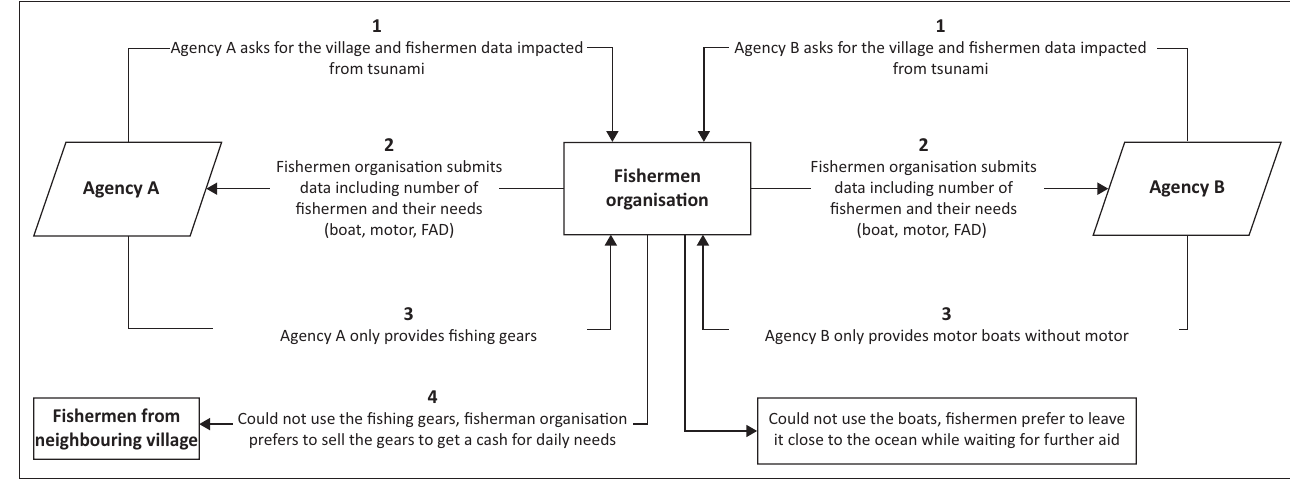
FIG URE 3: Management flow diagram on the practice of agency-driven recovery by Agencies A and